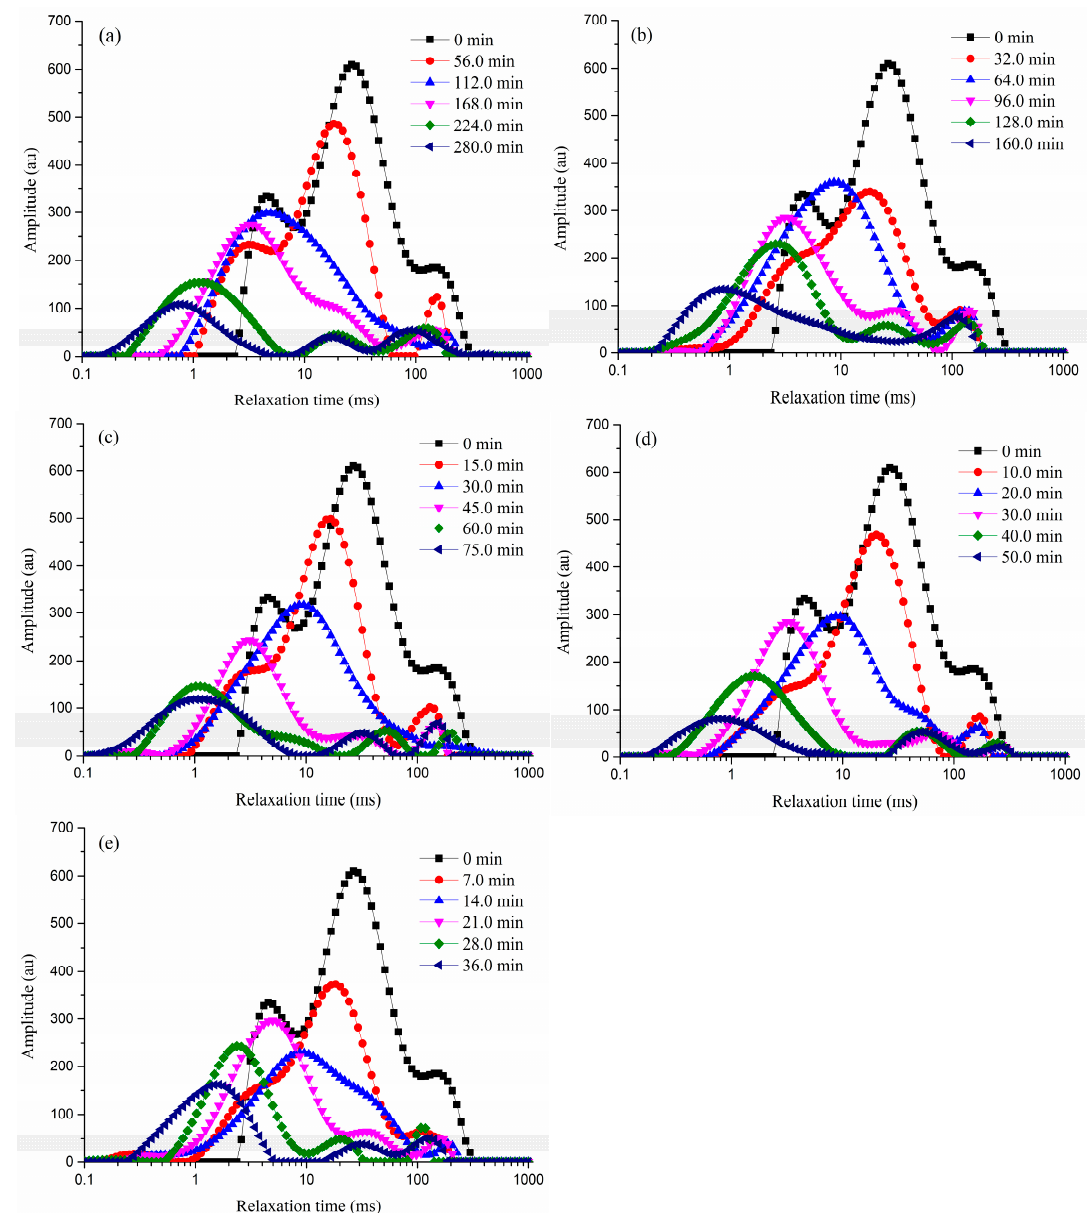
Figure 2. Distribution of T2 relaxation times of samples that underwent MVD at different microwave power settings: ( a ) 0.3 kW; ( b ) 0.5 kW; ( c ) 1.0 kW; ( d ) 1.5 kW; and ( e ) 2.0 kW.